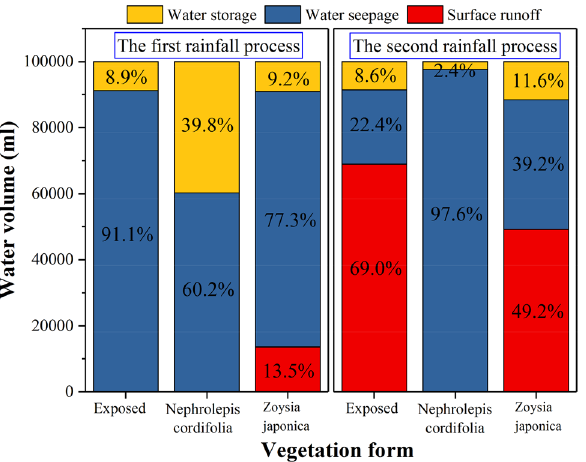
Figure 7. Distribution ratio of the rainfall patterns of the different vegetation-covered slopes.